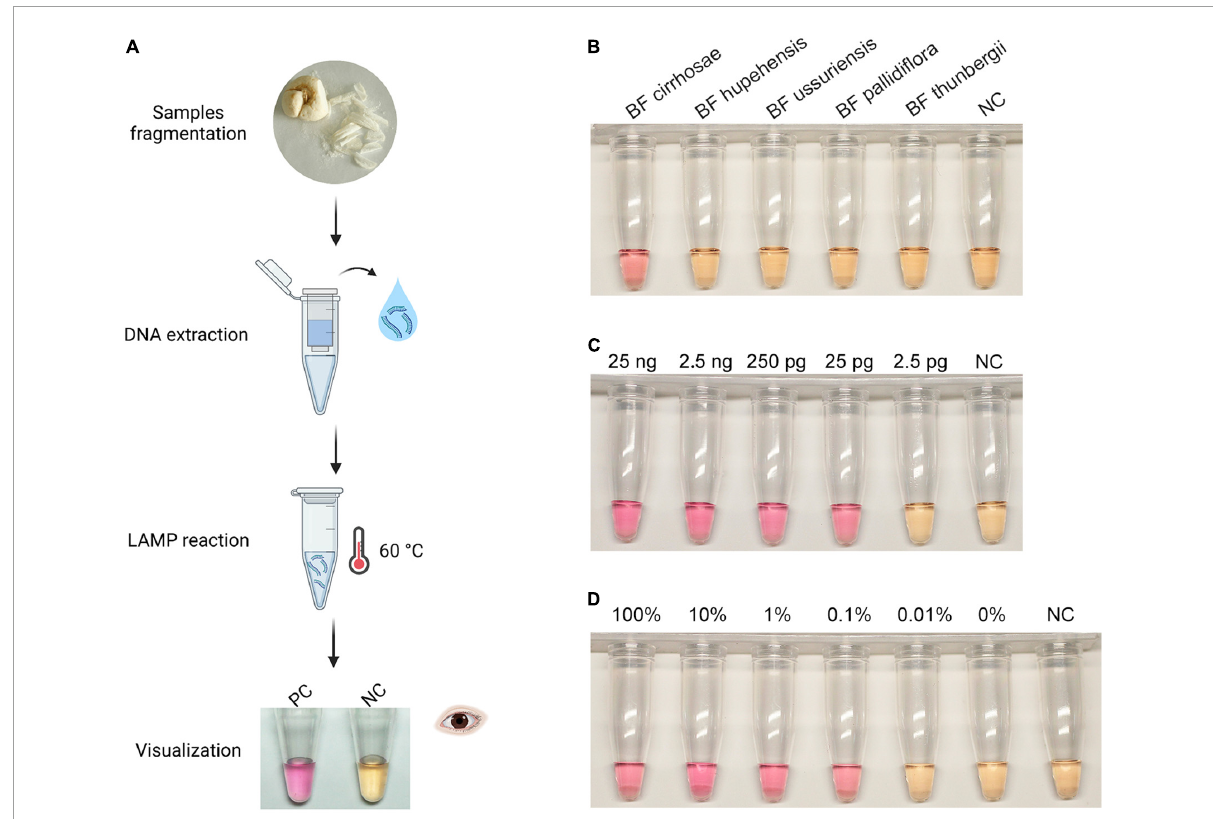
FIGURE4 Visualization of the Recombinase Assisted Loop-mediated isothermal DNA Amplification (RALA) amplification. (A) Workflow chart: the BF cirrhosae samples were fragmented firstly, and then the genome was extracted by column extraction. The obtained deoxyribonucleic acid samples were then subjected to RALA reaction (including pre-added N-Red) and incubated at 60 ◦ C for 80 min to obtain colorimetric detection results. (B) Specific colorimetric RALA detection of BF cirrhosae using pre-added N-red. (C) Colorimetric analysis of the sensitivity in the range of 25 ng to 2.5 pg. (D) Colorimetric detection of BF cirrhosae in mixed templates at varying percentages (100, 10, 1, 0.1, 0.01,